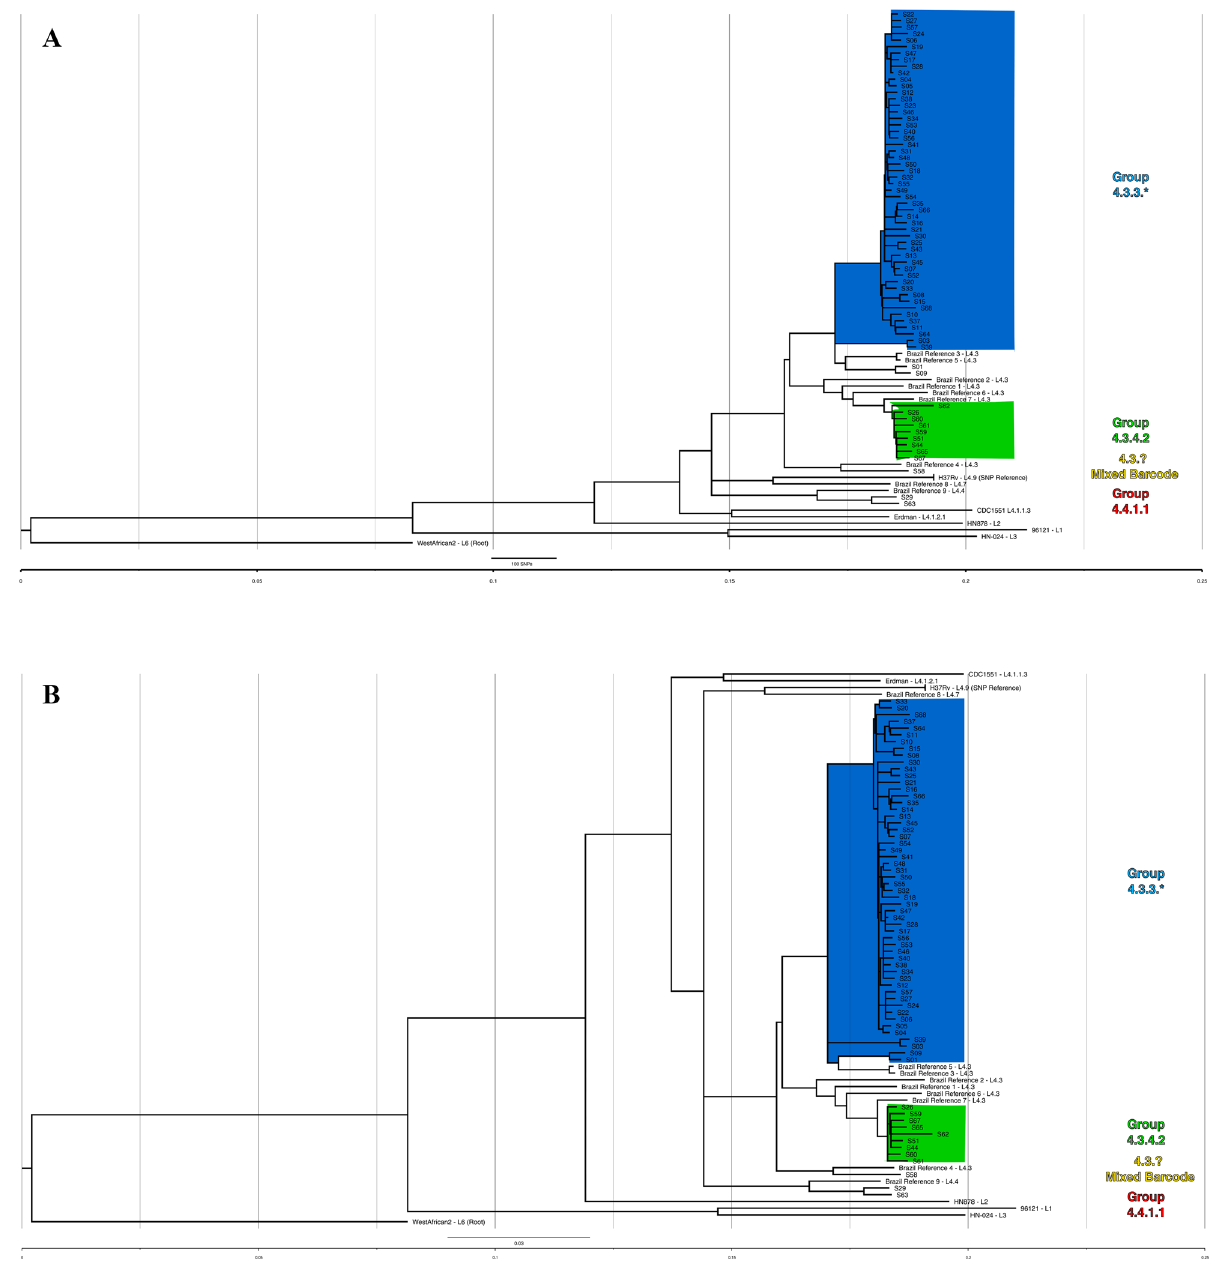
Figure 1. ( A ) Maximum likelihood (ML) tree showing SNP-based phylogenetic analysis of core SNPs extracted by snippy. Analysis by MEGA-X (default parameters, HKY model) with 500 bootstrap replicates. Tree with highest log likelihood is shown (− 53,357.07). Tree was visualized in FigTree, and labeling generated in Inkscape software. The tree is rooted to M. tuberculosis GM041182 (West African 2). The tree is drawn to scale, with branch lengths measured in average substitutions per site (7420 sites total). Bootstrap values are robust across the entire tree and are available in Supplemental 4. Pairwise distances are available in Supplemental 3. Coloring represents groups identified by Coll et al . ’s TB barcoding strategy, that groups the isolates based on the presence or absence of lineage- determining SNPs (Supplemental 2). The tree cleanly groups similarly barcoded TB isolates and suggests divergence of sampled isolates even from recent local reference isolates. ( B ) Bayesian consensus phylogram showing SNP-based phylogenetic analysis of 7420 core SNPs extracted by snippy. Analysis performed by MrBayes (GTR model, nst = mixed, mcmc = 500,000). Tree was visualized in FigTree, and labeling generated in Inkscape software. The tree is rooted to M. tuberculosis GM041182 (West African 2). All tree statistics and raw files are available in Supplemental 5. Coloring represents groups identified by Coll et al . ’s TB barcoding strategy available in Supplemental B. The tree demonstrates nearly identical grouping of all isolates as the maximum likelihood tree in ( A ) and lends even more support for barcoding-based grouping. ( C ) Maximum likelihood (ML) tree showing SNP-based phylogenetic analysis of core SNPs extracted by snippy without global reference lineages. Analysis by MEGA-X (default parameters, HKY model) with 1000 bootstrap replicates. Tree with highest log likelihood is shown (− 30,203.04). Tree was visualized in FigTree, and labeling generated in Inkscape software. The tree is rooted to M. tuberculosis H37Rv (Lineage 4.9). The tree is drawn to scale, with branch lengths measured in average substitutions per site (3863 sites total). Bootstrap values are labeled at branch points if greater than 70%, and any points where support falls under 70% is labeled in red and further values are not provided for the clade. Coloring represents groups identified by Coll et al . ’s TB barcoding strategy available in Supplemental 2. Without global reference lineages, barcoded isolates still group reliably. S09/S01 and S03/S39 (blue clade, bottom four isolates) stand out by branch lengths as divergent from rest of blue